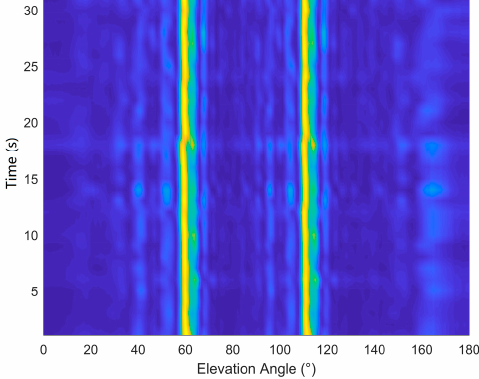
Figure 18. Power output after conventional beamforming processing (main lobe of 111° and grazing lobe of 61°).